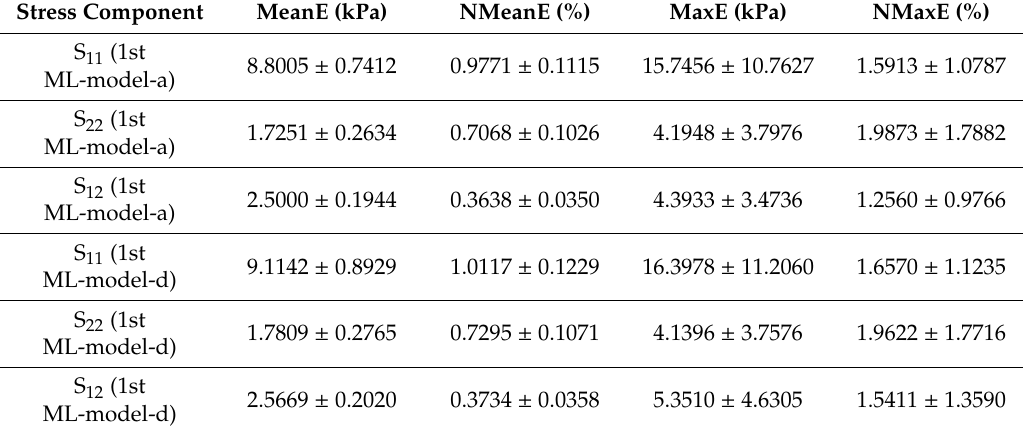
Table 2. Performance measures for the prediction of TAV leaflet stress fields ( ρ = 90).